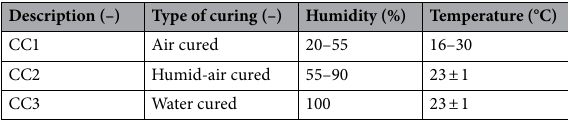
Table 3. Curing conditions for cementitious mortar samples.